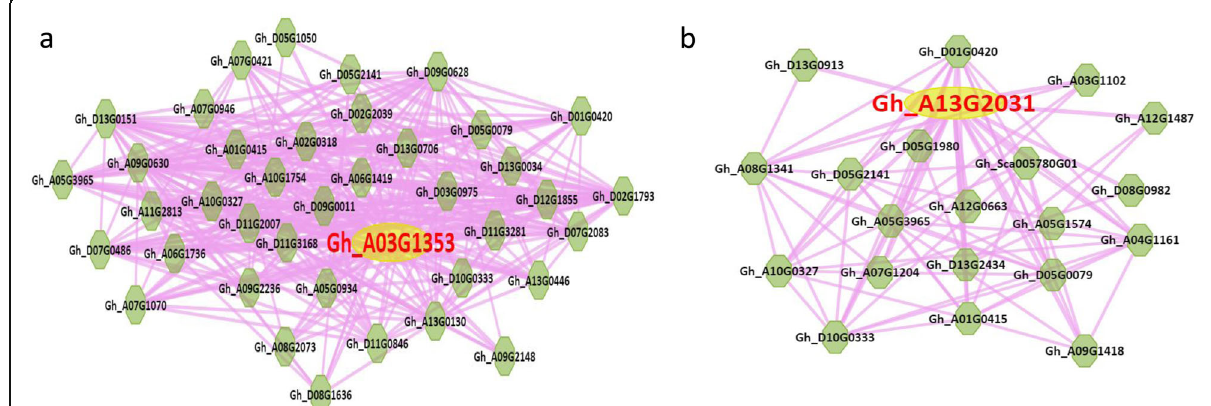
Fig. 3 Co-expressed genes with GhGT47A1 ( Gh_A03G1353 ) and GhGT47B1 ( Gh_A13G2031 ). Protein in yellow elliptic box represents query protein. Proteins in green hexagon boxes represent interaction proteins. Pink interaction line indicates protein has interaction and positive co-expression relationship with target protein. In ( a) , Gh_D07G2083 , Gh_D05G0079 , Gh_A05G3965 , Gh_D10G0333 and Gh_A10G0327 were annotated as homologs of secondary cell wall cellulose synthase, Gh_D02G1793 was annotated as IRX10 homolog, Gh_A13G0130 , Gh_D13G0151 and Gh_A06G1419 were annotated as homologs of DUF231 domain proteins. In ( b) , Gh_D05G0079 , Gh_A05G3965 , Gh_A10G0327 and Gh_D10G0333 were annotated as homologs of secondary cell wall cellulose synthase, Gh_A09G1418 was annotated as IRX9 homolog, Gh_D13G2434 was annotated as FRA8 homolog, Gh_A07G1204 was annotated as MYB61